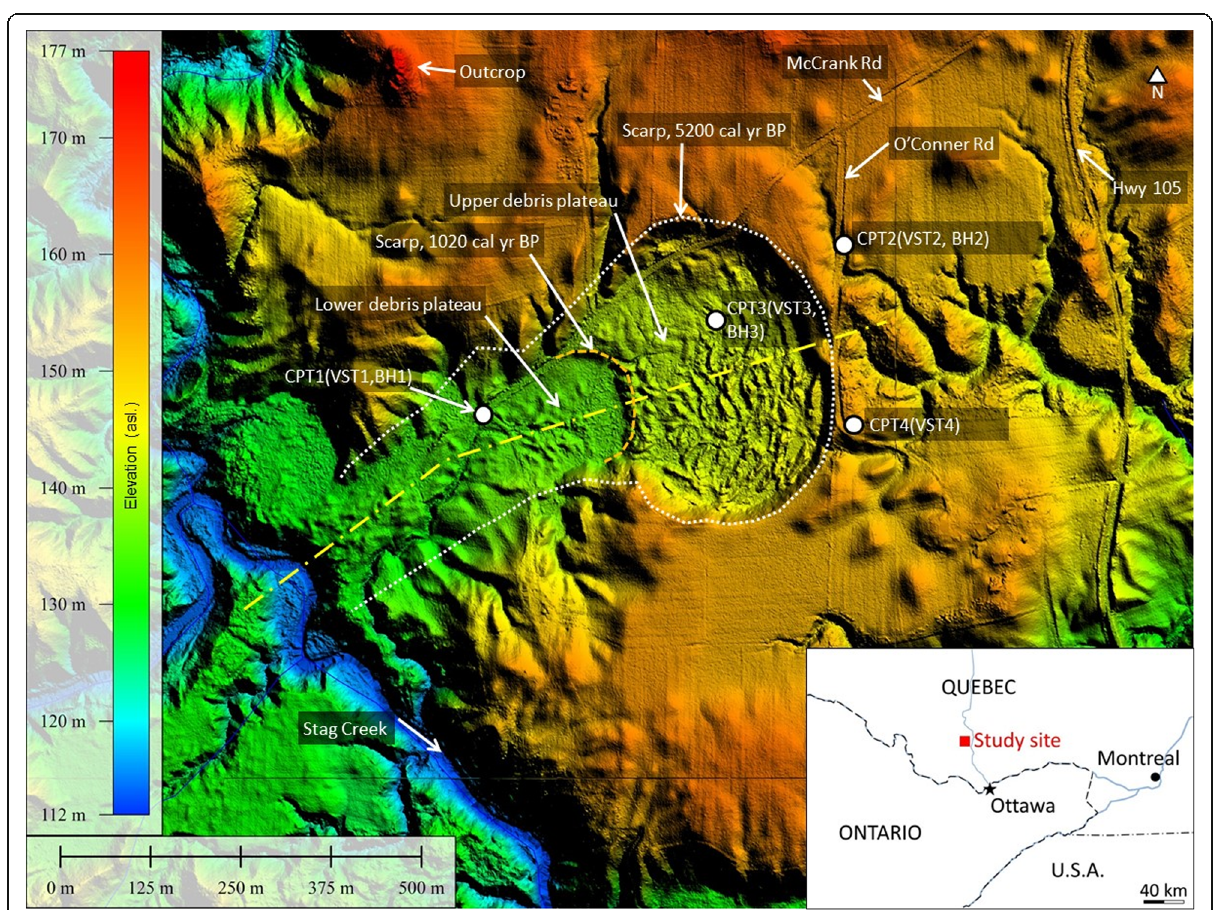
Fig. 7 Low landslide site (LiDAR image©Government of Quebec. White dotted line marks the perimeter of the large failure zone of 5200 cal BP. Orange dashed line is the boundary between an upper debris plateau and a lower debris plateau or headscarp of the 1020 cal BP failure. The yellow dash-dotted line is the approximate centerline where slope stability is